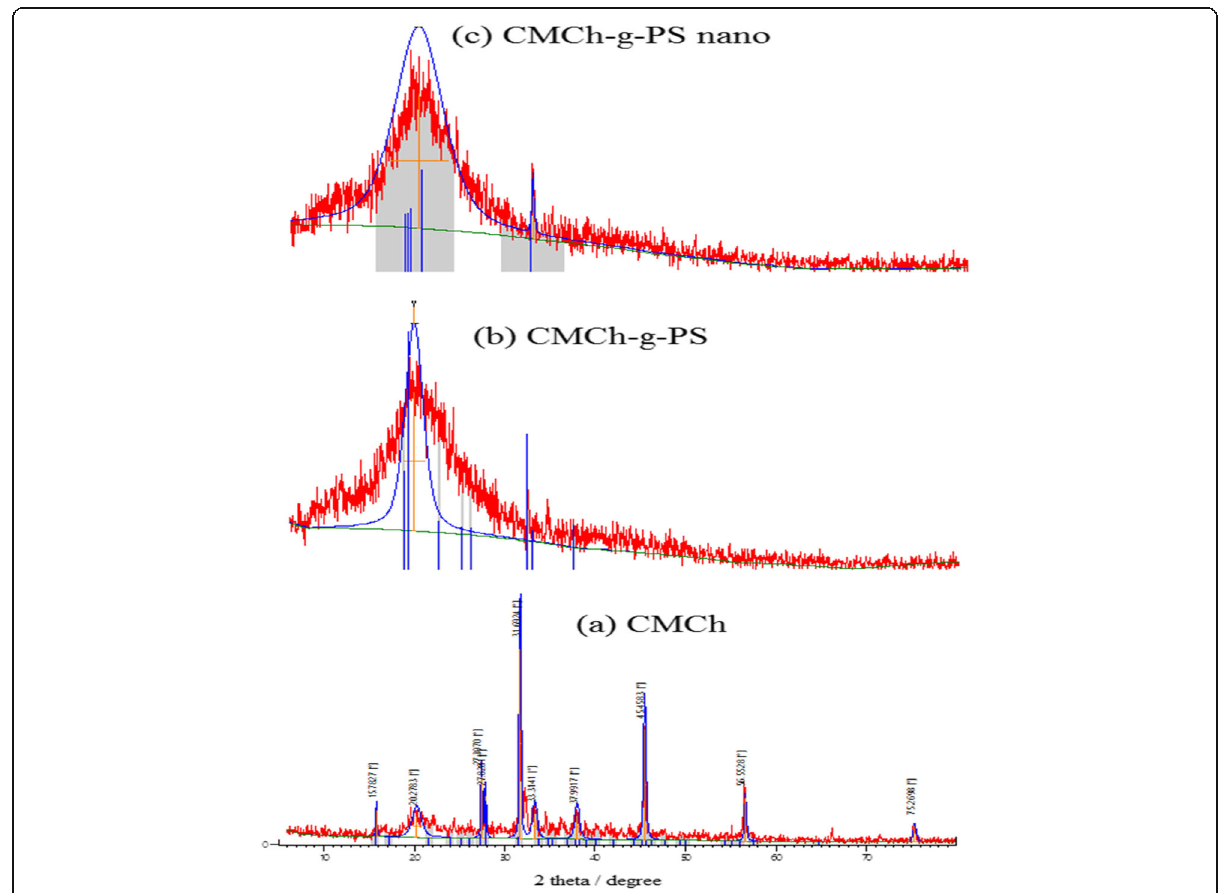
Fig. 6 X-ray diffraction patterns of ( a ) CMCh, ( b ) CMCh-g-S, and ( c ) CMCh-g-S nano at optimum grafting